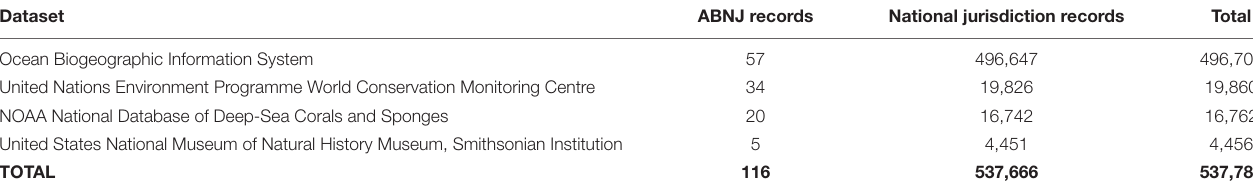
TABLE 1 | Number of unique coral records examined as part of this study by jurisdiction and dataset (ABNJ = areas beyond national jurisdiction).